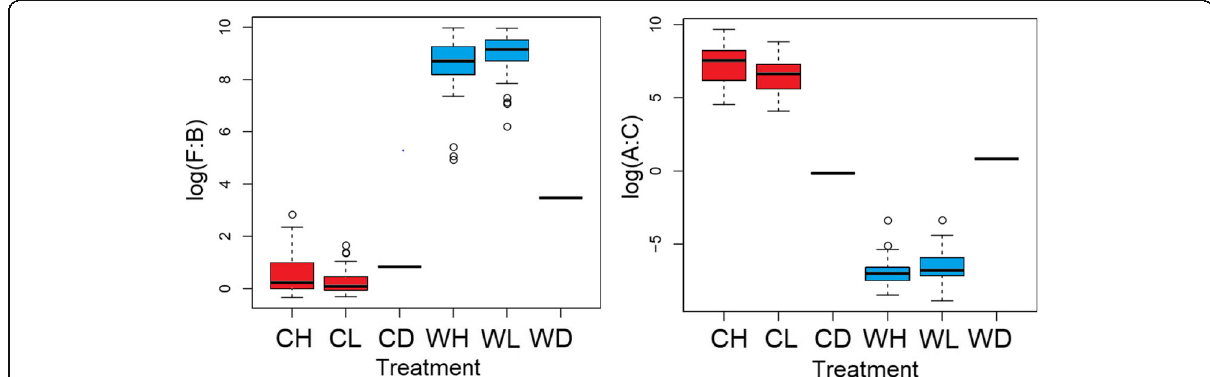
Fig. 5 Firmicutes:Bacteroidetes ratio in fecal samples upon sacrifice (left). Wild High and Wild Low groups have a high relative abundance of Firmicutes and no Bacteroidetes. WH and WL thus had a significantly higher F:B ratio than CH and CL ( p<0.0001, Wilcox). Akkermansia:Clostridium ratio (right). Captive High and Captive Low groups have a high relative abundance of Akkermansia and little Clostridium. CH and CL groups thus had a significantly higher A:C ratio than WH and WL (p<0.0001, Wilcox